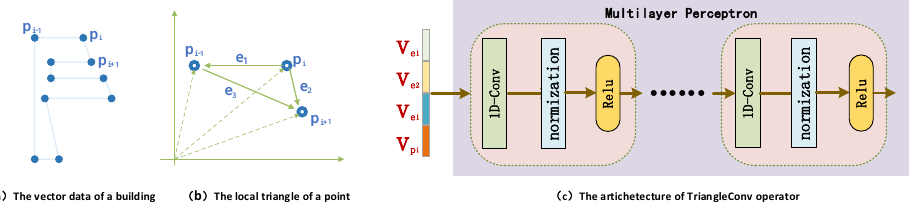
Figure 2. TriangleConv operator. ( a ) The vector data of a building; ( b ) the local triangle constructed by a point and its two adjacency points; ( c ) the architecture of the TriangleConv operator. For the function h in the formula (1), there are many candidate implementations.